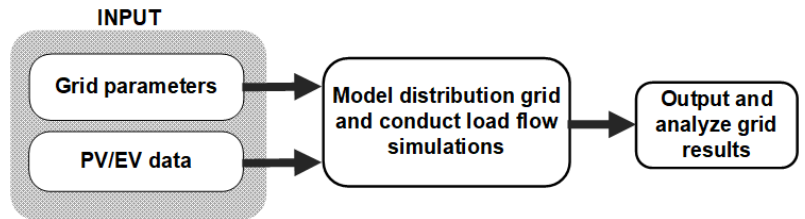
Figure 3. Deterministic method illustration.